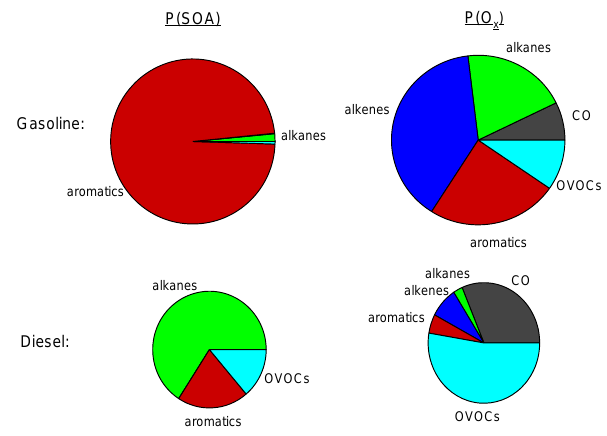
Fig. 8. Relative contributions of VOC classes to SOA and O x pro- duction calculated using VOC emission factors for gasoline and diesel-fueled vehicles and Eqs. (2) and (3) (“gaseous only, no UCM” case). Pie charts not shown to